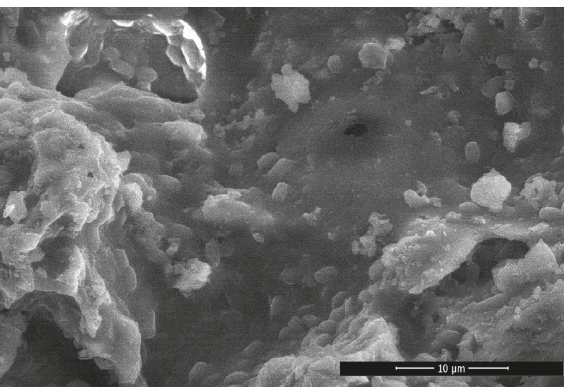
Figure 5: SEM images of spores loaded in ceramsite.